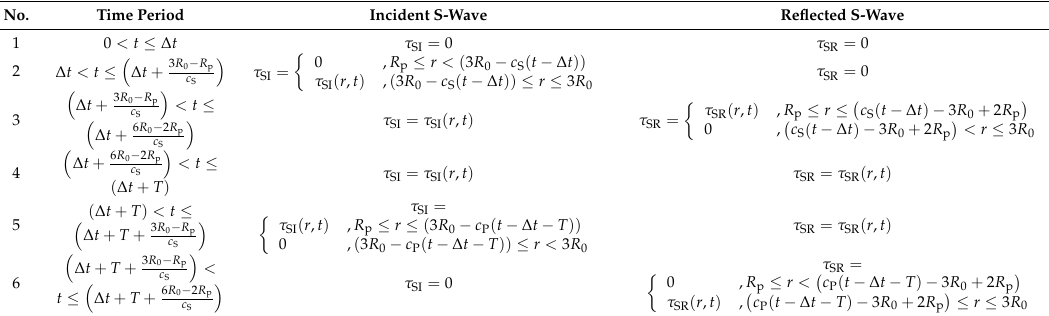
Table 2. S-wave functions according to the division of time periods in Figure